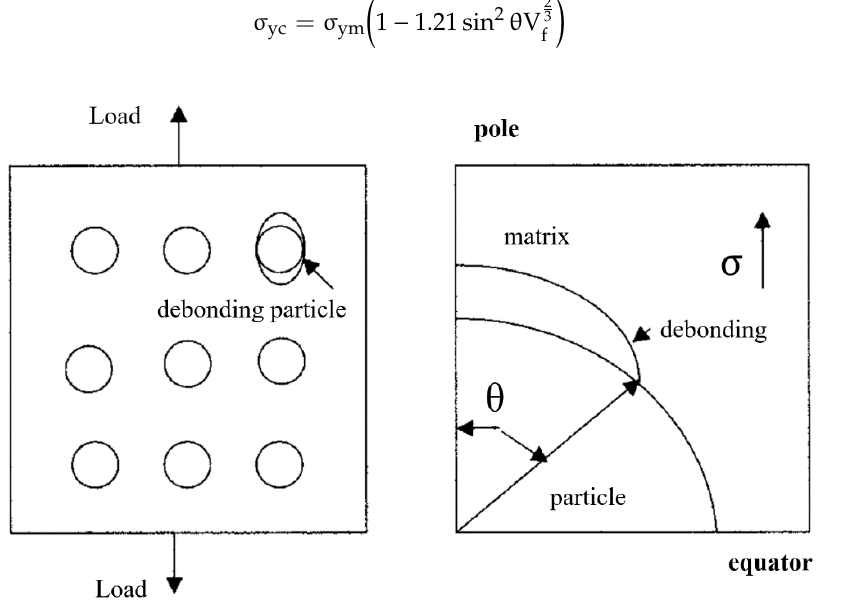
Figure 22. Interfacial debonding model [67].